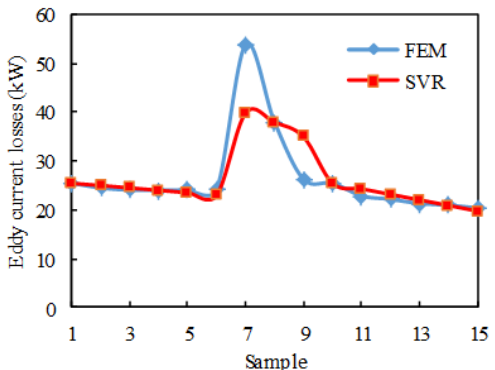
Figure 14. Learning results based on SVR.